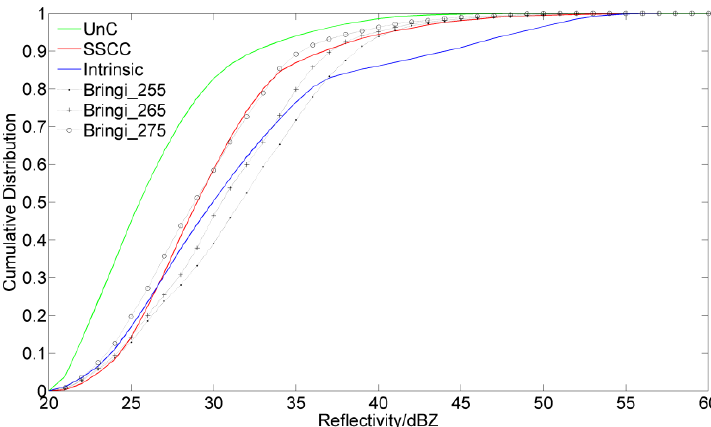
Figure 21. Cumulative distribution of reflectivity with different initial phases for the stratiform rain with embedded convection.